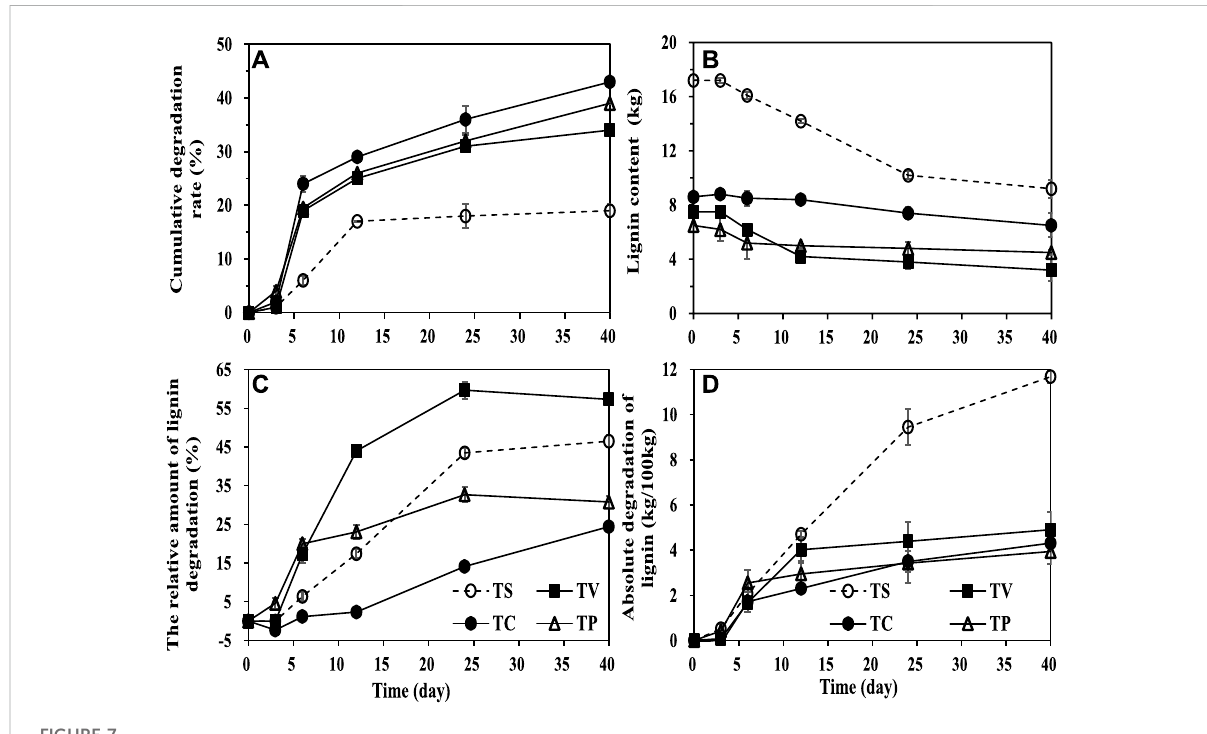
FIGURE 7 The degradation rate changes in the raw material and lignin in single material